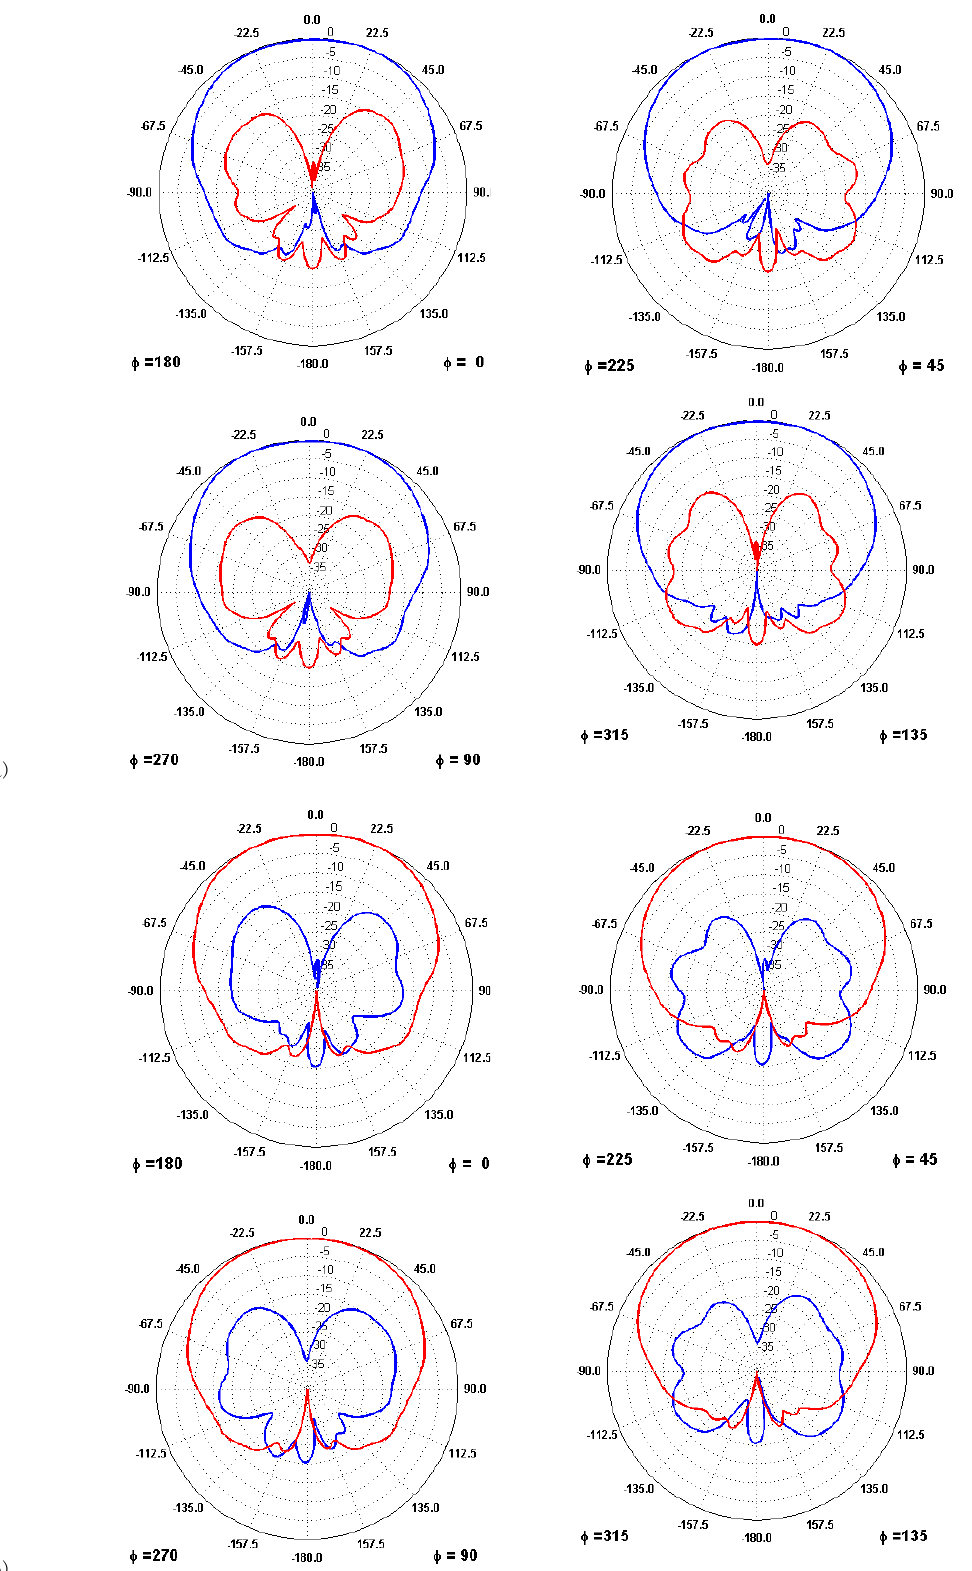
Figure 2. ( a) Co-polar (RHCP, blue) and cross-polar (LHCP, red) RHCP antenna pattern. (b) Co-polar Figure 2. ( a ) Co-polar (RHCP, blue) and cross-polar (LHCP, red) RHCP antenna pattern; ( b ) Co-polar (LHCP, blue) and cross-polar (RHCP, red) RHCP antenna pattern. Cuts at φ = 0 ° , 45 ° , 90 ° , and 135 ° , (LHCP, blue) and cross-polar (RHCP, red) RHCP antenna pattern. Cuts at ϕ = 0 ◦ , 45 ◦ , 90 ◦ , and 135 ◦ , as indicated. as